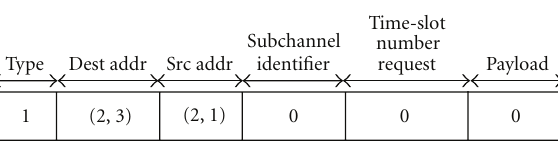
Figure 13: SDM-TDM set-up packet node source (2,1).